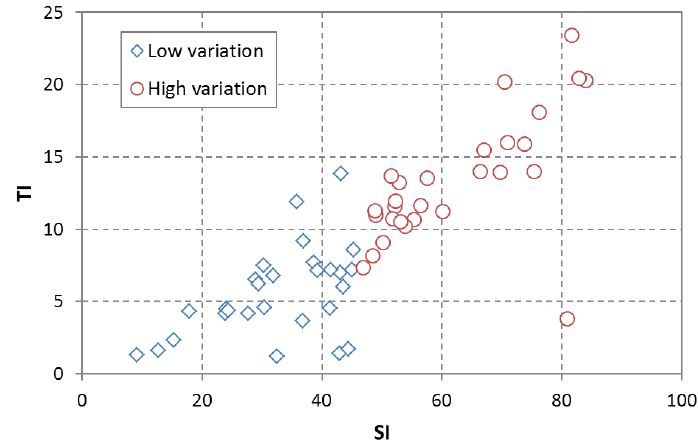
Figure 2. Scatter diagram for Spatial and Perceptual Information in test scenes.